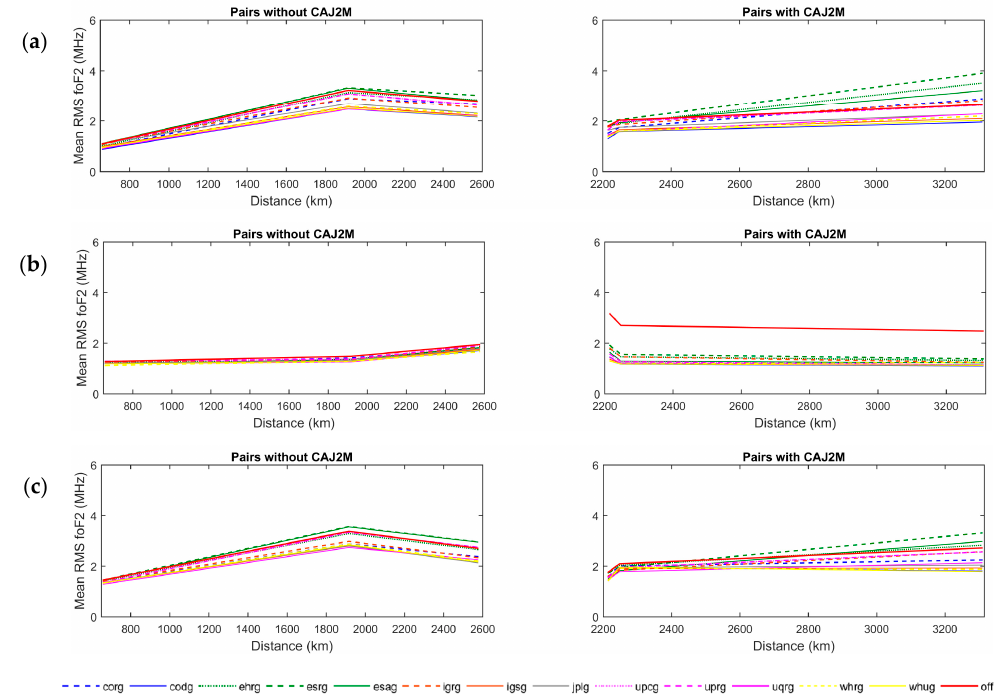
Figure 10. Mean RMS of the di ff erences between fo F 2 values measured at the ionosondes and estimated using GIMs versus the distance of the ionosondes pairs considering one-week data divided into pairs formed with ionosondes at di ff erent (right) and similar (left) latitudes: ( a ) test week (020-026 / 2015); ( b ) low (166-172 / 2015); ( c ) high (288-294 / 2015) ionospheric electron content.